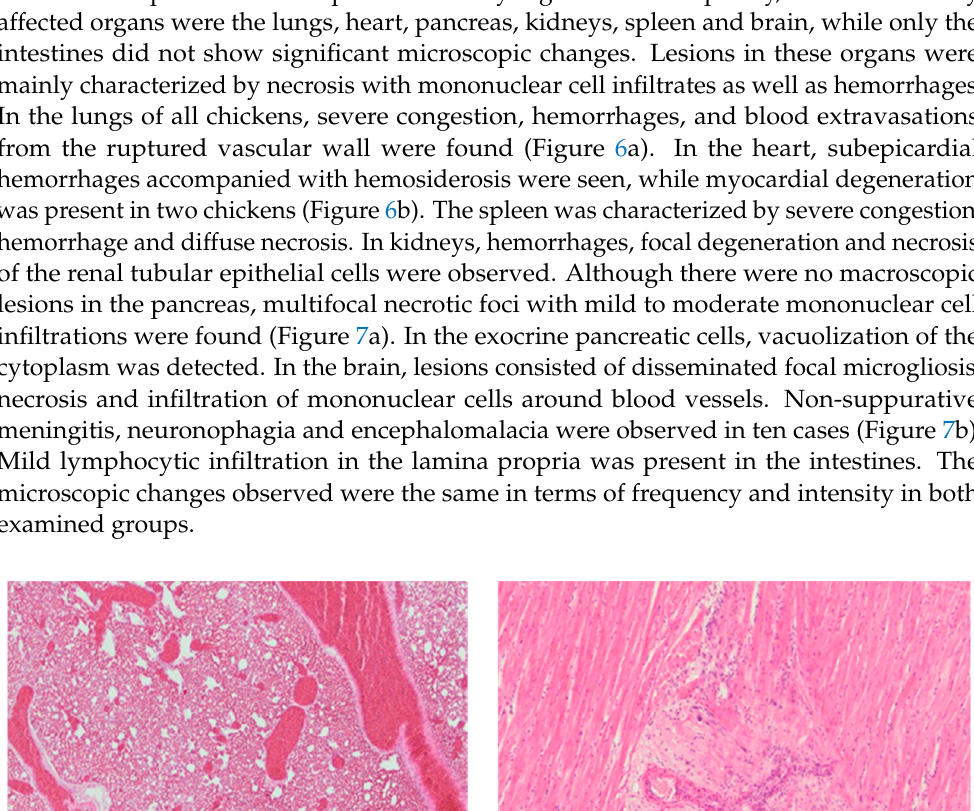
Figure 5. Gross lesions in chickens naturally infected with HPAI H5N1. ( a ) Pancreas, multifocal, partially coalescing hemorrhages. ( b ) Multiple necrotic foci 0.1 to 0.5 mm in diameter in the pan- creas.